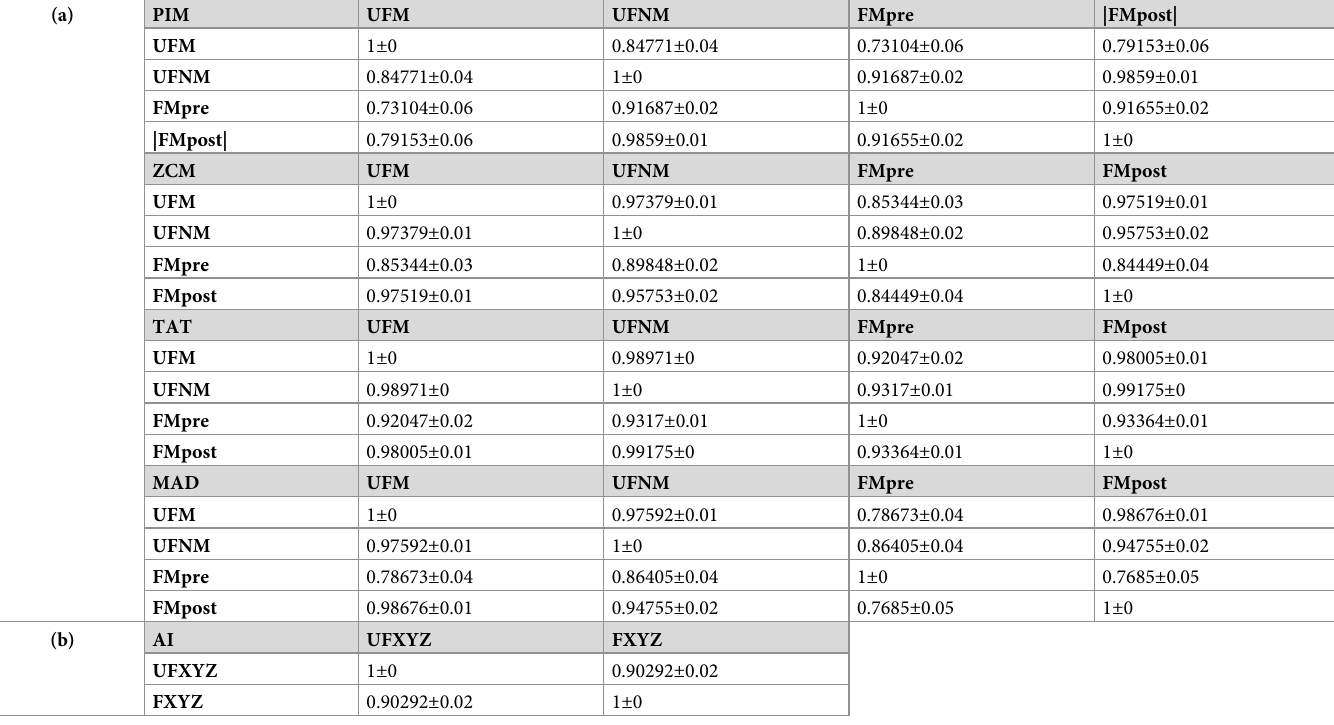
Table 2. The effect of the normalization and filtering presented by the correlations of the activity signals calculated using the same metric, but different preprocess- ing methods.